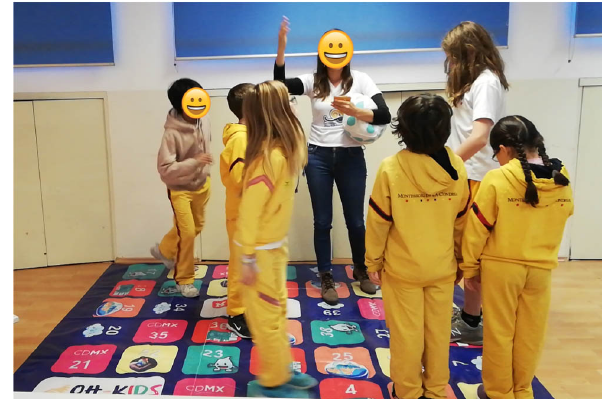
Figure 7. A small group of students playing Hydro-thon during one of the workshops.